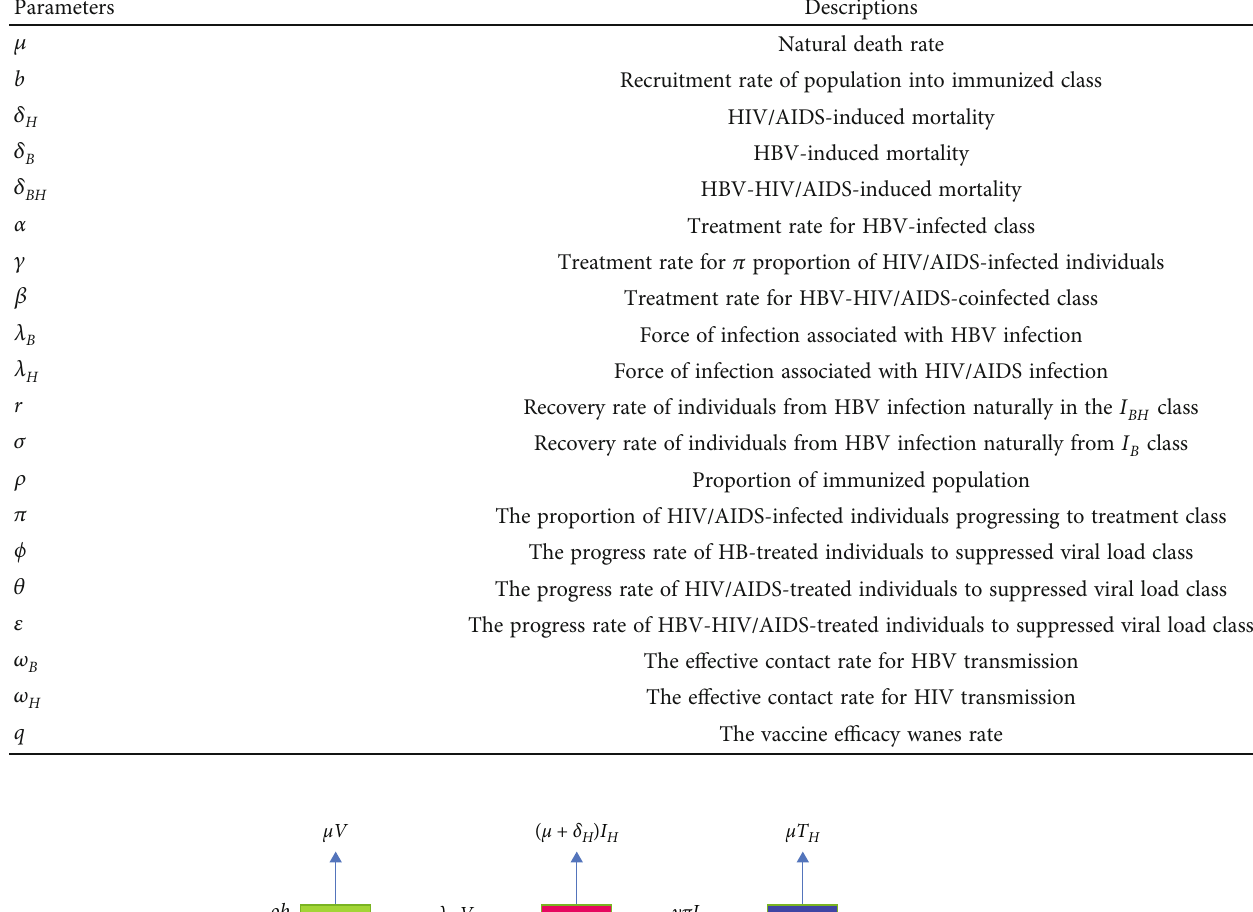
Table 1: Parameters and their description of the model.